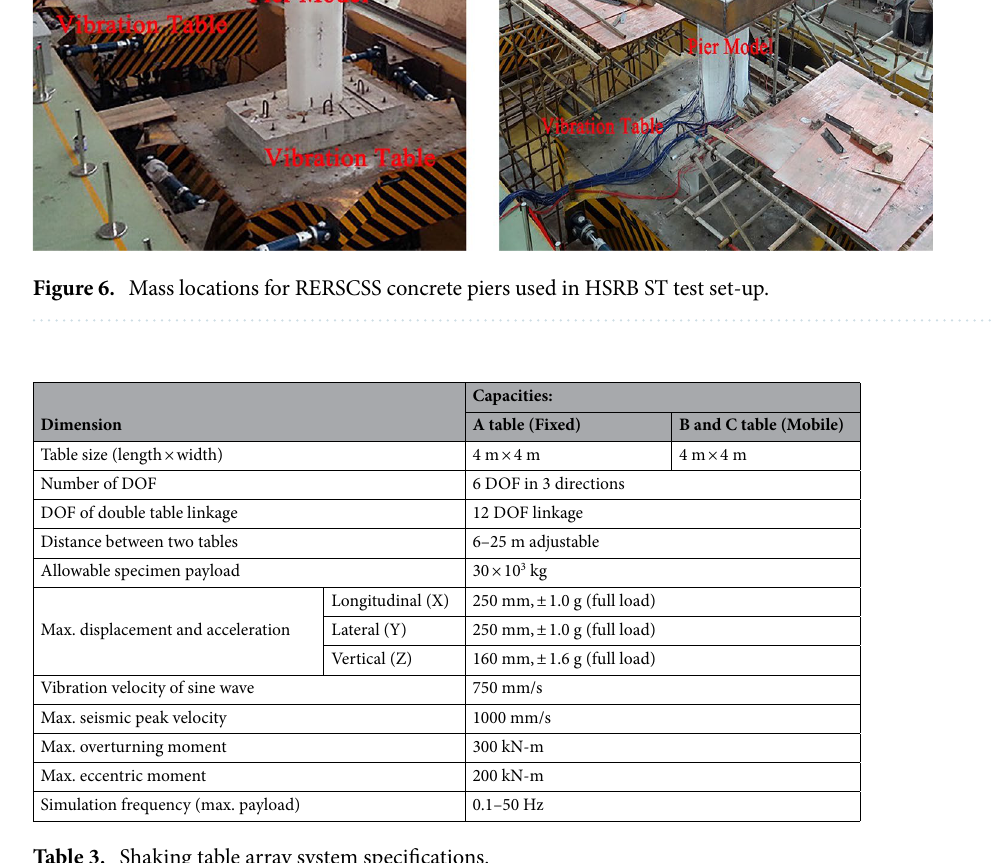
Table 3. Shaking table array system